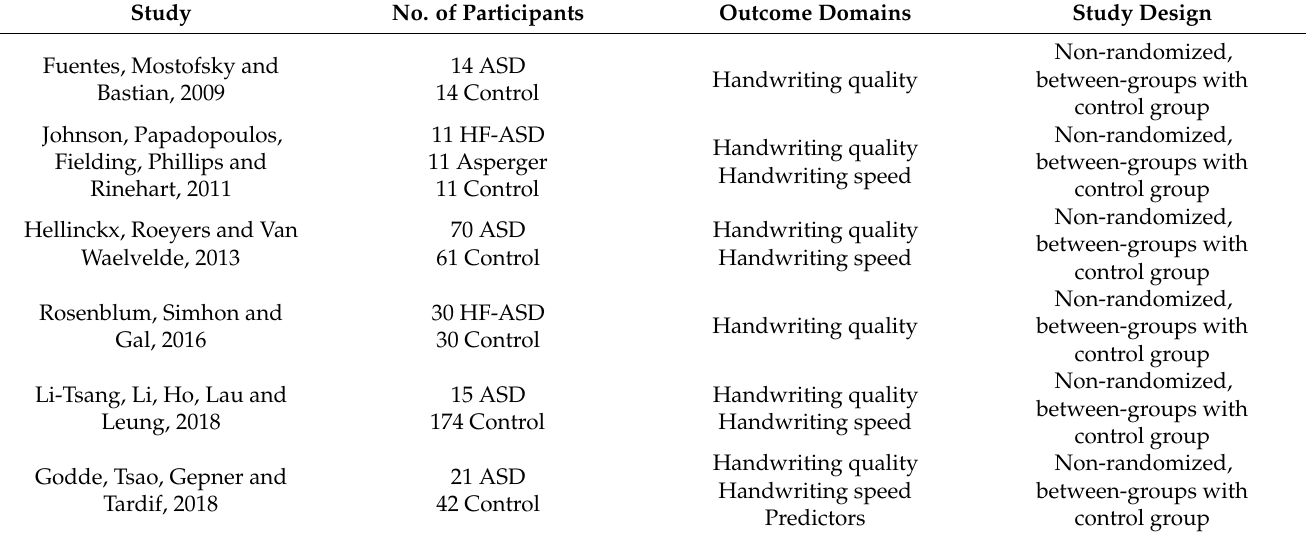
Table 1. A summary of the reviewed studies examining handwriting in ASD in terms of sample sizes, primary outcomes and study